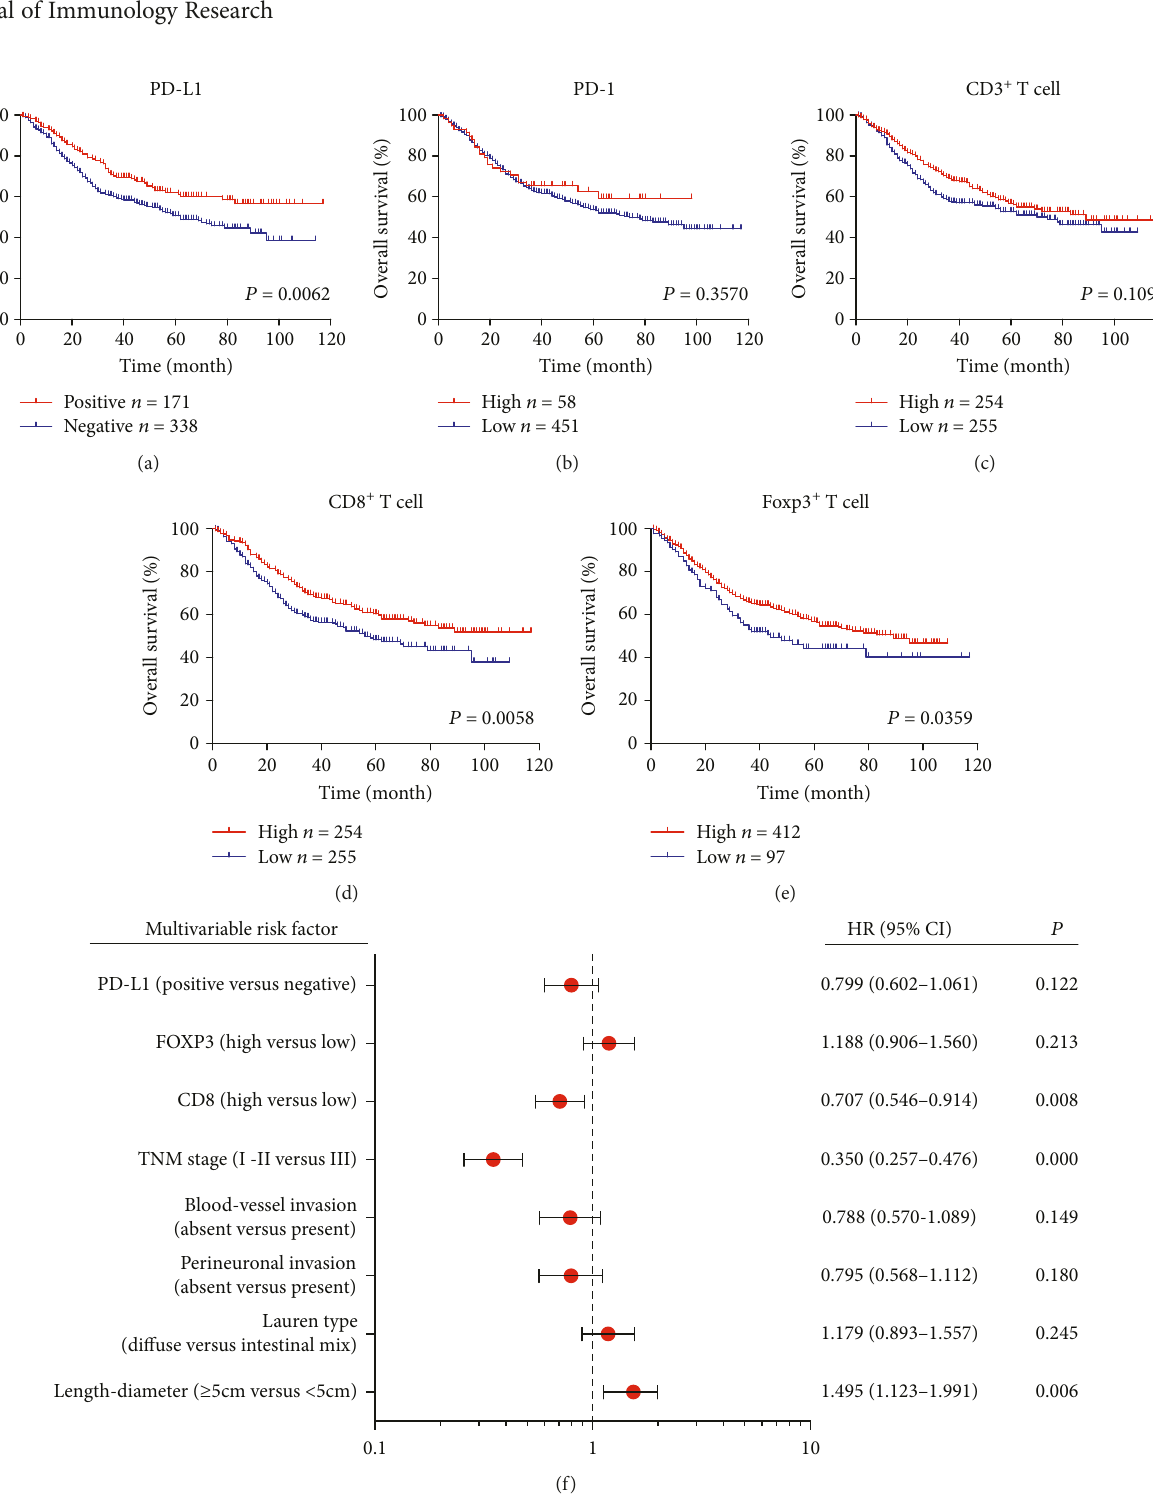
Figure 4: Prognostic value of tumor PD-L1 expression and T cell in fi ltration in AGC patients. (a) Kaplan-Meier survival curves for OS based on PD-L1, PD-1, CD3, CD8, and FOXP3 status. (b) After univariate analysis, we selected statistically signi fi cant risk factors, including PD-L1, FOXP3, CD8, and other clinicopathological parameters, for multivariable